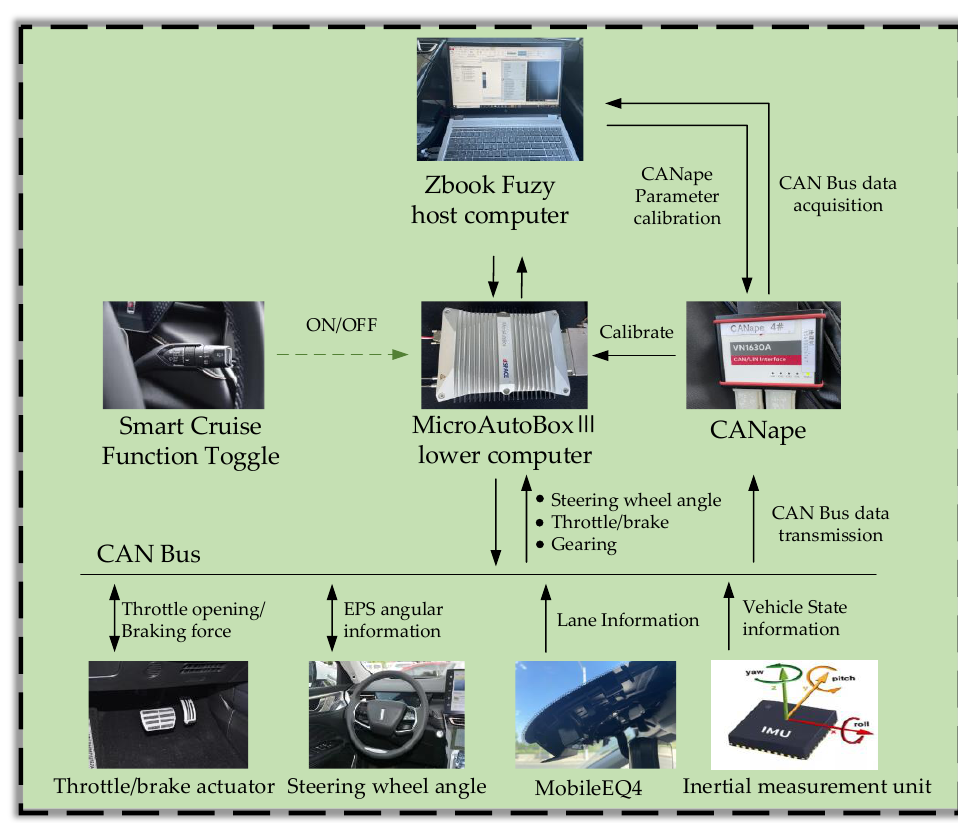
Figure 12. Path tracking control vehicle hardware system.